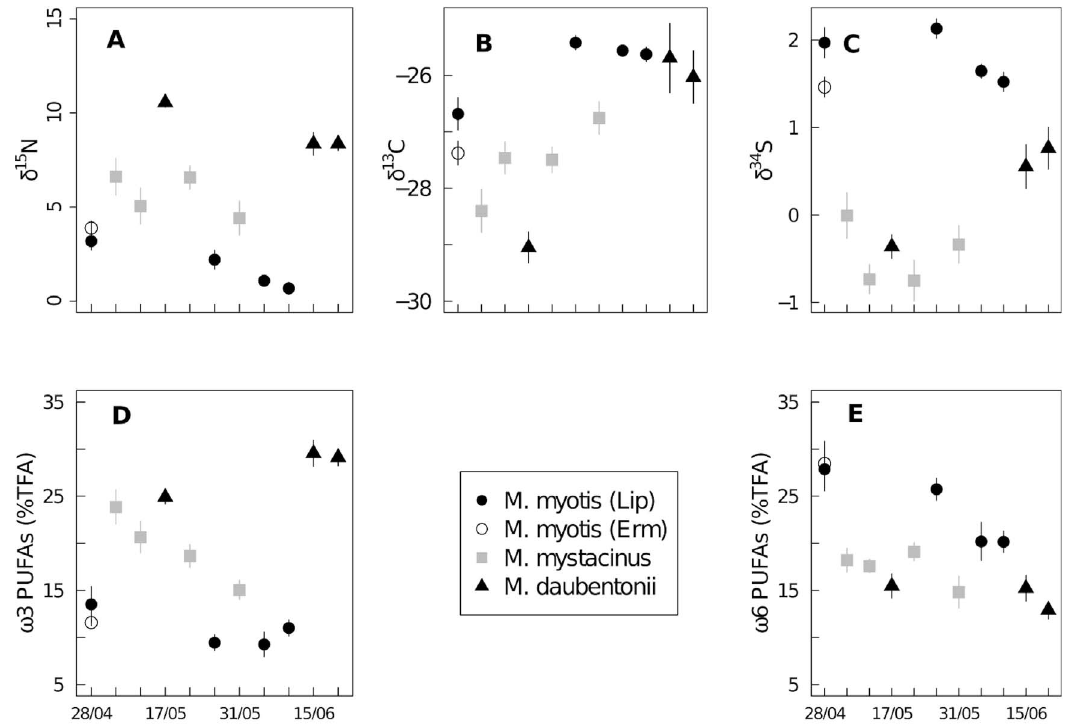
Figure 3. Temporal patterns of stable isotope and PUFA values per species. Temporal patterns (means 6 SE) in A. d 15 N, B. d 13 C, C. d 34 S, D. v 3 PUFAs and E. v 6 PUFAs values for Myotis myotis , M. daubentonii and M. mystacinus . Lip: Lipperswil, Erm: Ermatingen.